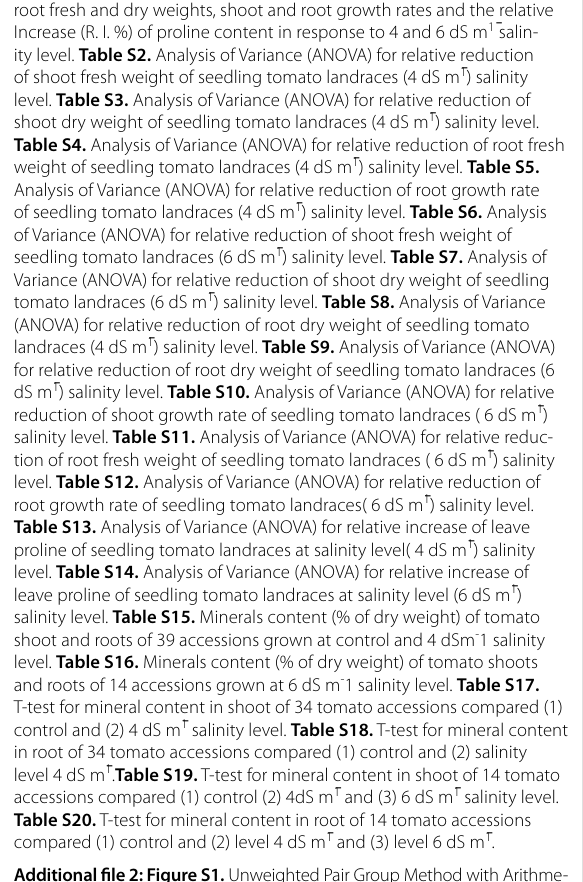
Additional file 2: Figure S1. Unweighted Pair Group Method with Arithme- tic average (UPGMA) dendrogram of the genetic dissimilarity of the tomato